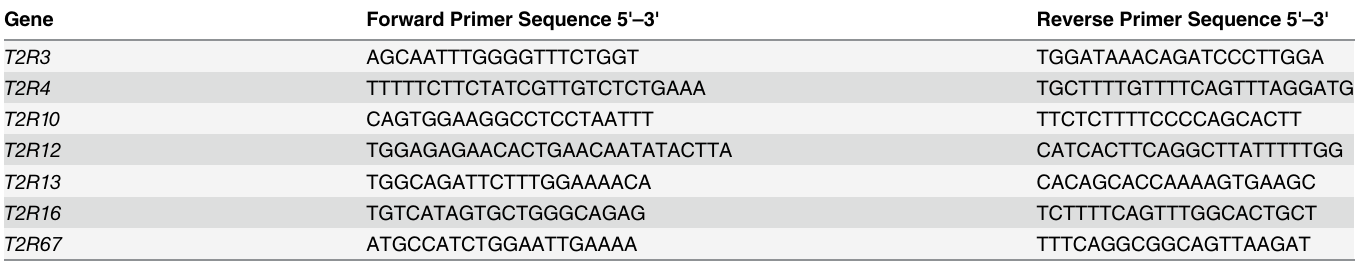
Table 1. Sequences of the primer sets used for each T2R gene amplification and sequencing.